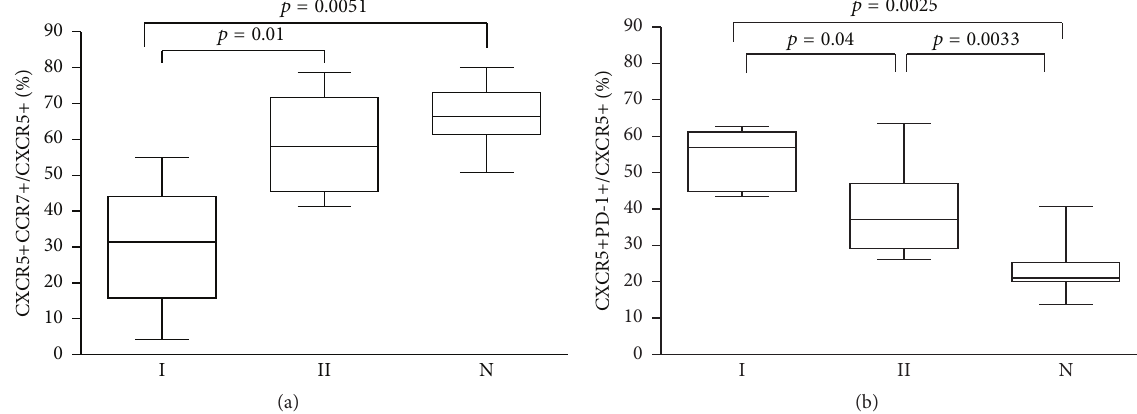
Figure 3: CCR7 and PD-1 expression in T FH of CVID patients. The percentage of CCR7+ cells within the CXCR5+CD4+ T lymphocyte region was calculated for CVID Group I and Group II patients and N (% CXCR5+CCR7+/CXCR5+) (a). Likewise, the percentage of PD-1+ cells in the CXCR5+CD4+ T lymphocyte region was determined (CXCR5+PD-1+/CXCR5+) (b). Statistical differences are consigned in the